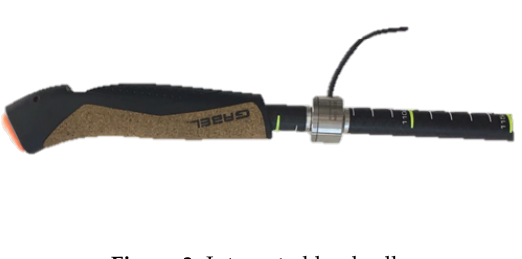
Figure 3. Integrated load